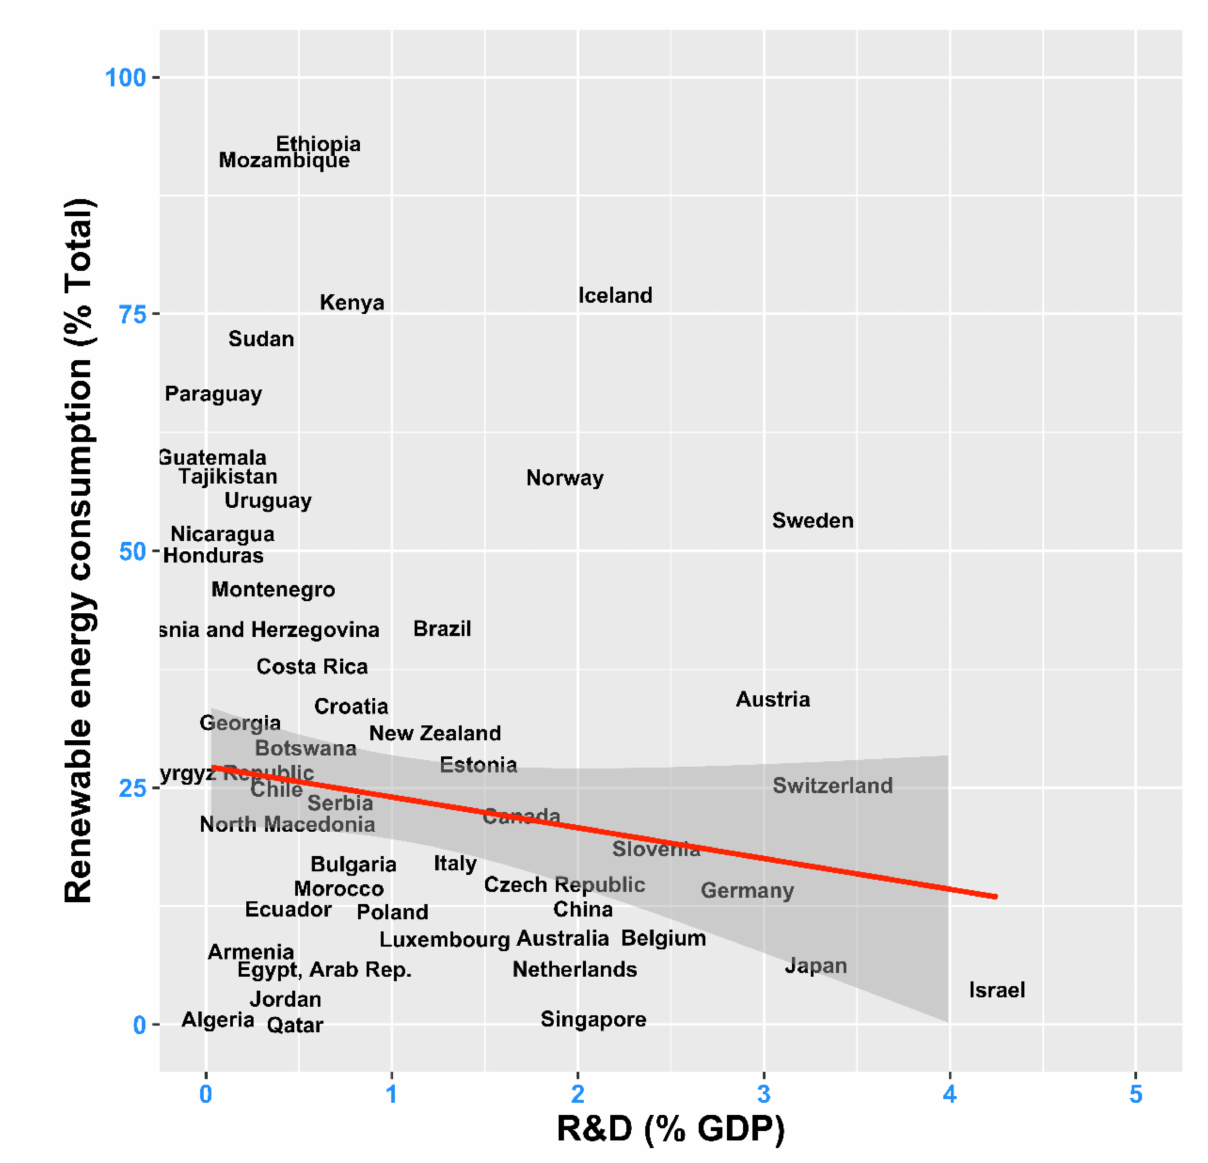
Figure 3. R&D Expenditure (% of GDP) and REC (% of total final energy consumption), most recent year of available data per country. Source of data: World Bank’s Development Indicators (WDI)